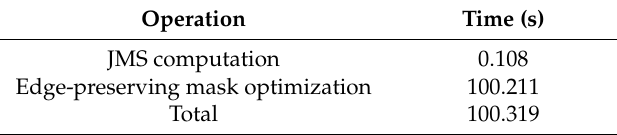
Figure 9. Edge-preserving mask optimization.